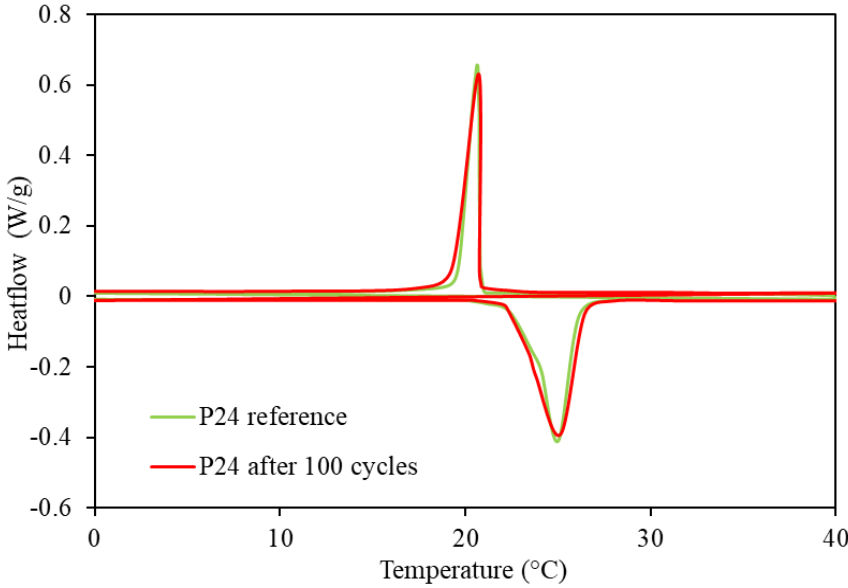
Figure 5. Long-term stability of developed plaster — mixture P24 after 100 cycles. Looking at the plotted curves, the onset and endset temperatures did not display any distinct shift or drop. The onset phase change temperature during cooling was moved slightly from 20.69 °C